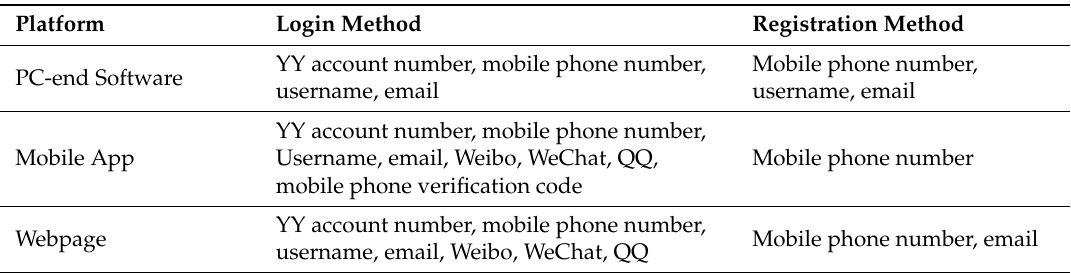
Table 3. YY user login and registration